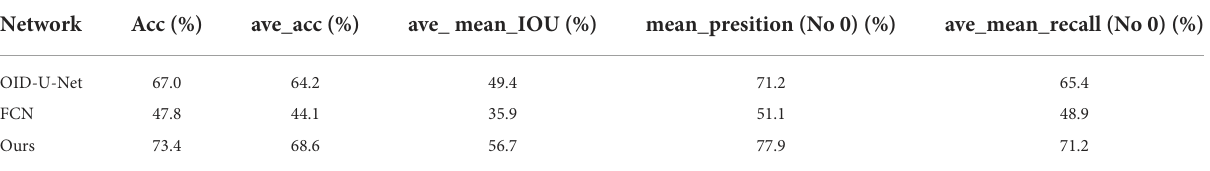
TABLE 4 Comparison of evaluation metrics for different networks using dual data stream training